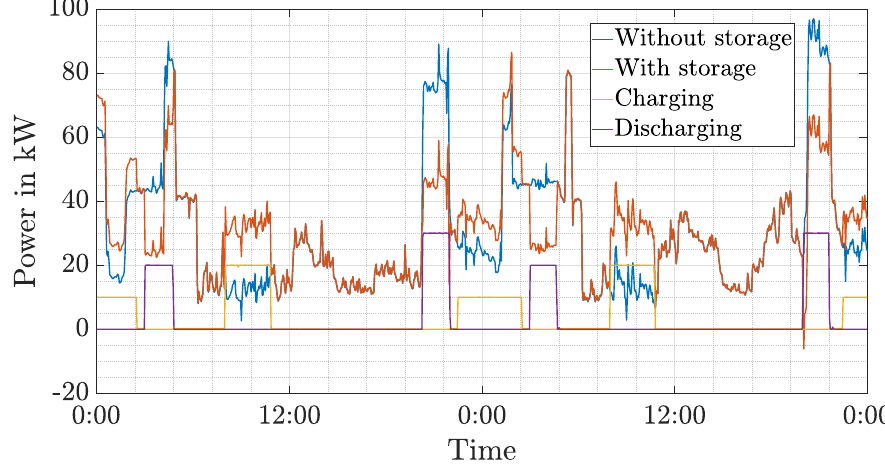
Figure 12. Results after the removal of the malfunction for the fixed schedule